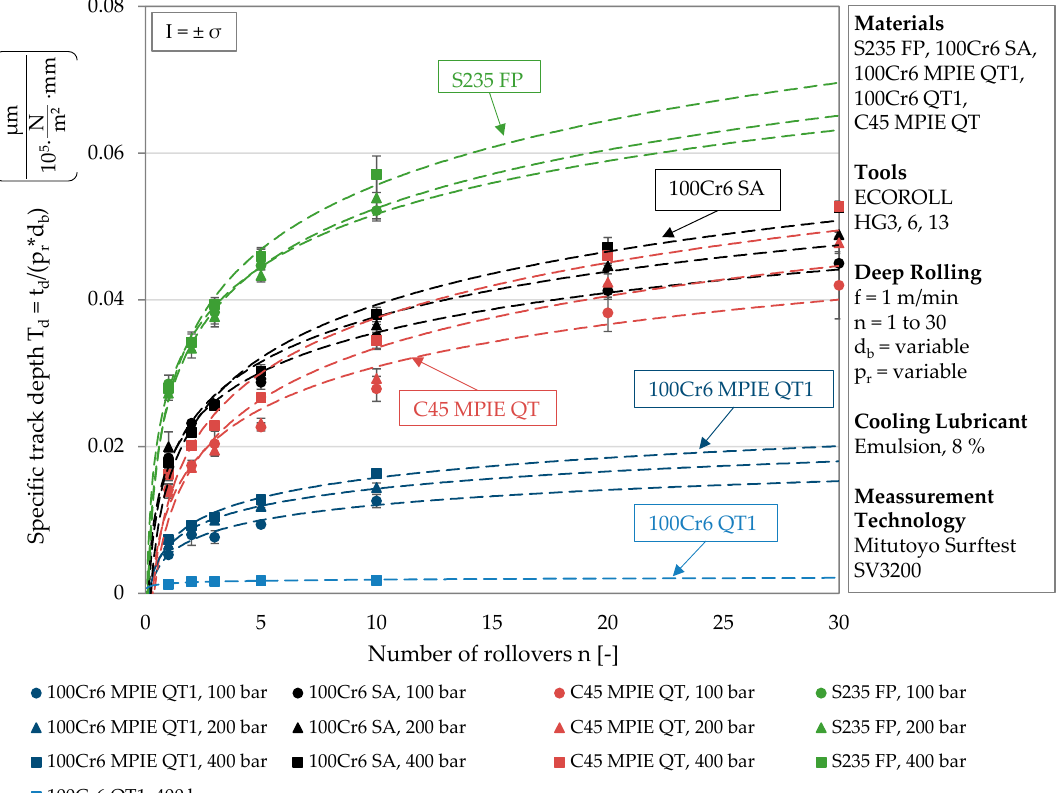
Figure 5. Material-dependent specific track depth as a function of the number of rollovers.